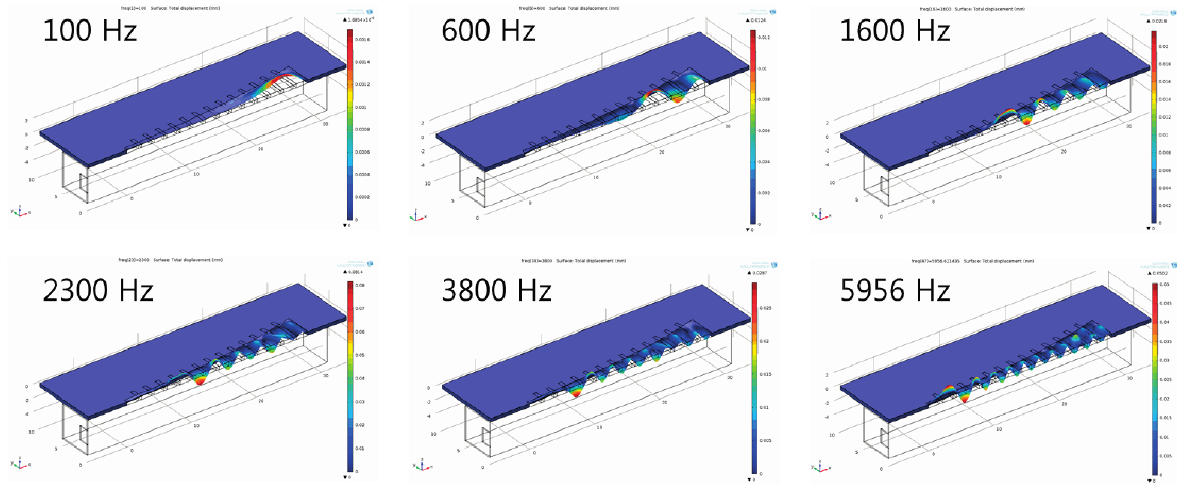
Figure 4. Frequency separation analysis with finite element model of the designed PAC with a liquid chamber: The membrane deformation indicates relative local resonant displacement of the membrane. Position of maximum resonant displacement (MRD) at each local resonant frequency (LRF) moves closer to base area at higher frequency (graphs not drawn to scale).